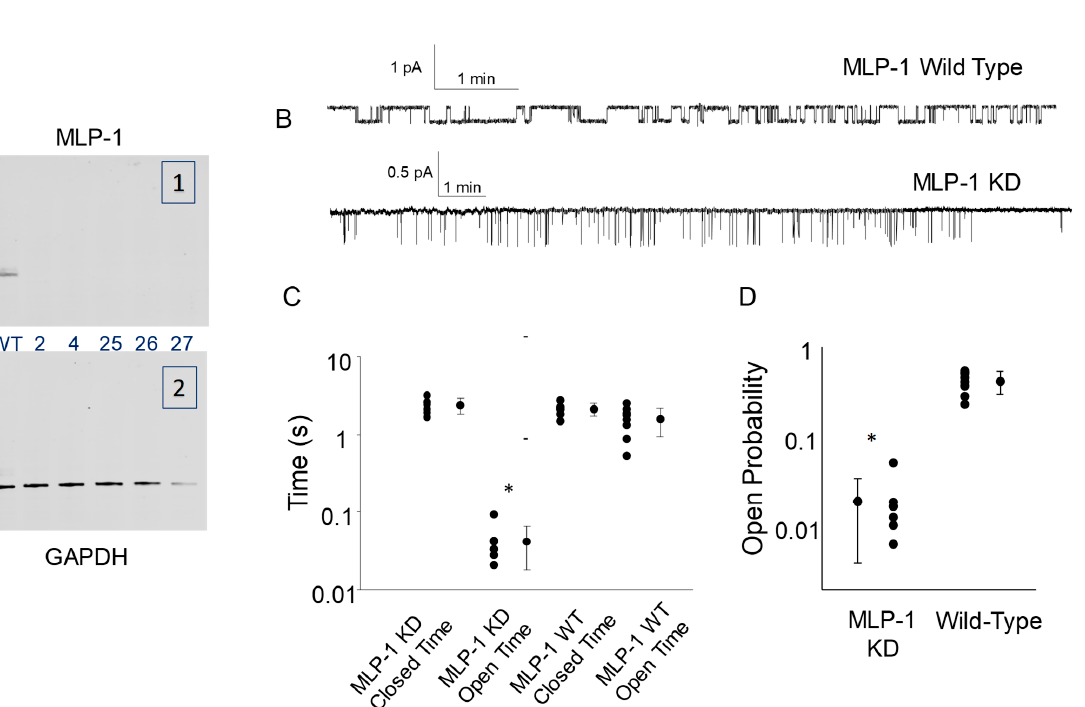
Values were determined according to the formulas described in Methods for the images in Figure 4 using the colocalization threshold plugin of the FIJI image analysis program.